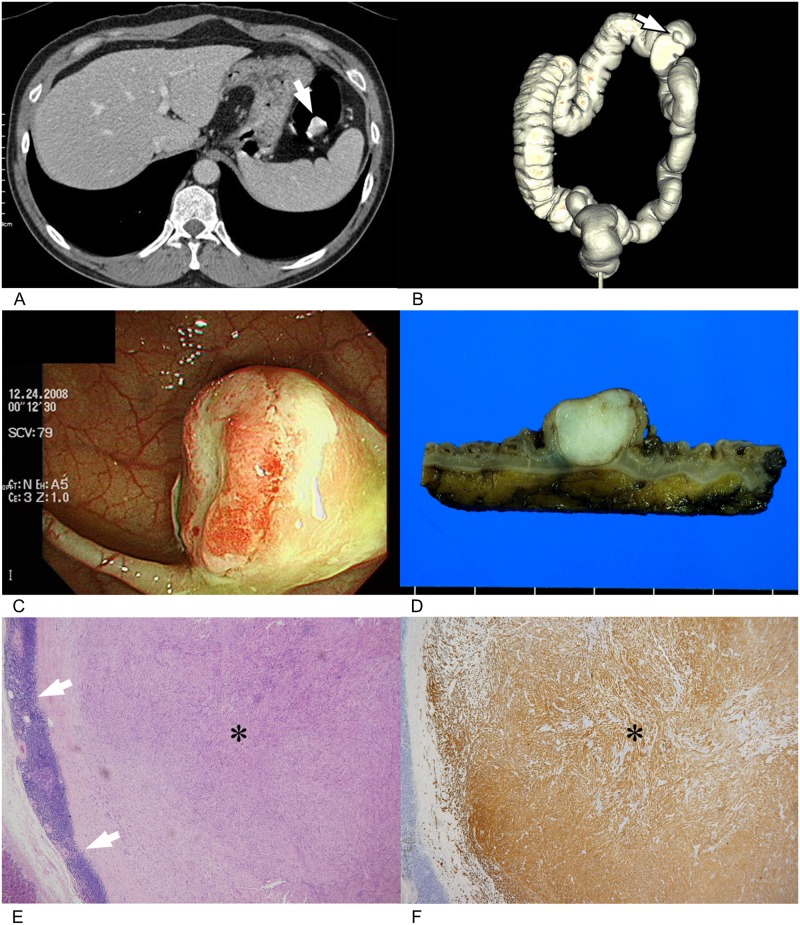
A 45-year-old man with colonic schwannoma.(A). On axial (A) images of CT colonography (CTC), a 1.7 cm endophytic lesion (arrow) is seen at the distal transverse colon. The lesion shows homogenous high attenuation compared to back muscle. There were no surface ulceration or calcification in the lesion. (B). Opaque (B) images of volume rendering CTC also demonstrate the lesion (arrow). (C). Colonoscopy shows an endophytic subepithelial lesion with surface ulceration. (D). A photograph of cut surface of gross specimen obtained after left hemicolectomy shows a well-defined endophytic subepithelial nodule in the colon. (E). On low-power field microscopic examination (H&E, x10), spindle cell tumor (*) is surrounded by characteristic peripheral lymphoid cuffs (arrows). (F). Tumor cells (*) are diffuse and strongly S-100 protein positive on immunohistochemistry and confirmed as colonic schwannoma involving the submucosa and proper muscle. Reactive hyperplasia was noted at 16 lymph nodes in the resected specimen (not shown). H&E = hematoxylin and eosin.